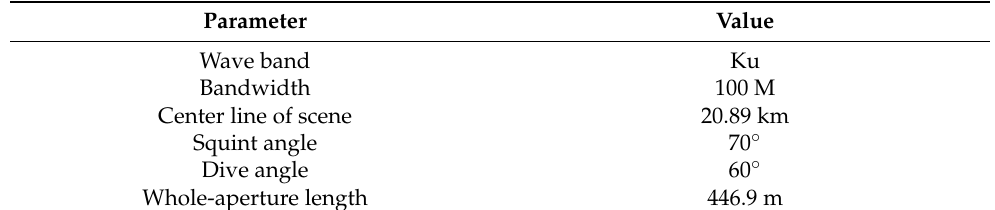
Table 1. Main system parameters.